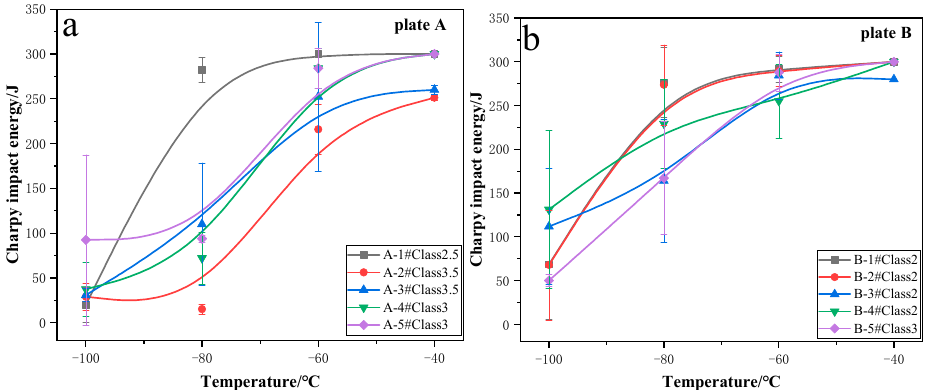
Figure 3. Charpy impact energy of strips from slabs with different segregation degrees: ( a ) Plate A; ( b ) plate B.